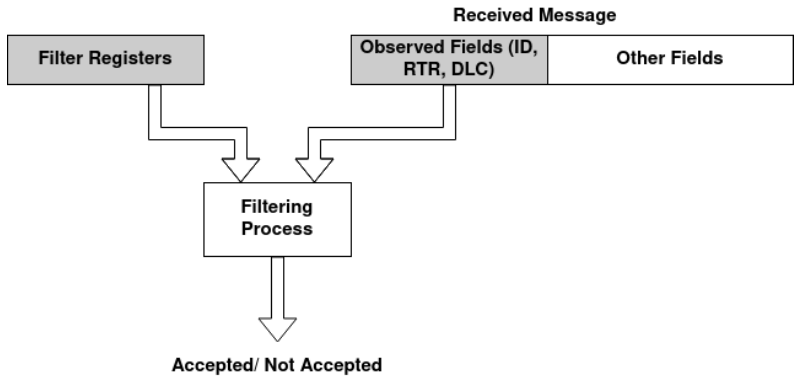
Figure 2. Acceptance filter module.